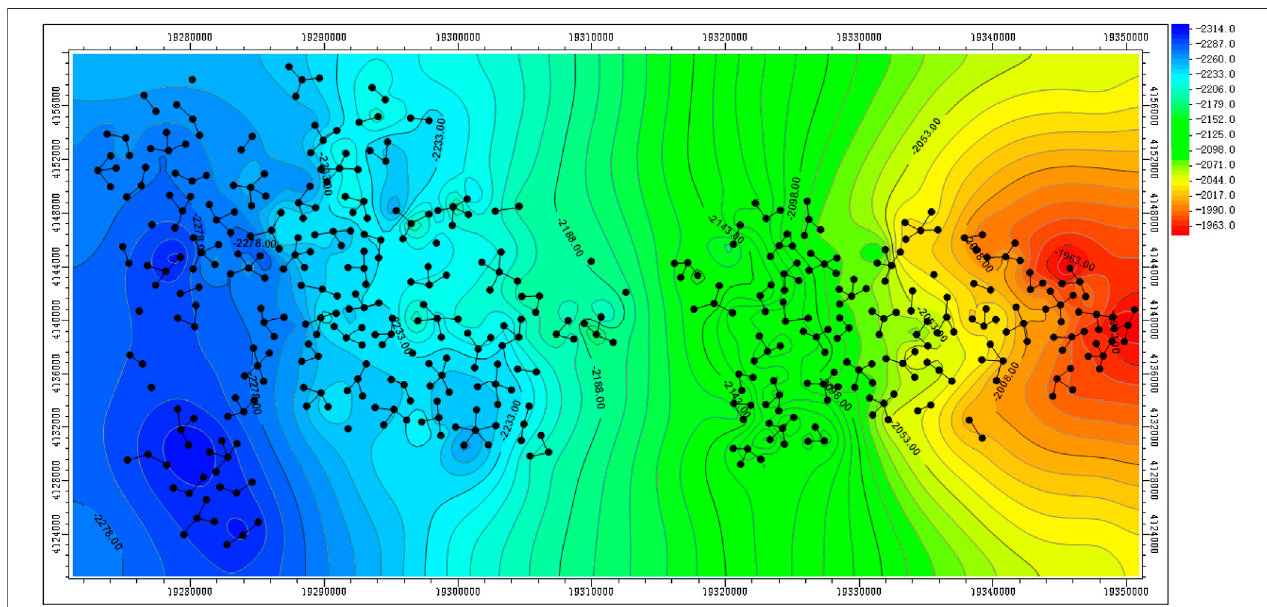
FIGURE 1 | Tectonic map of the top surface of reservoir formation.